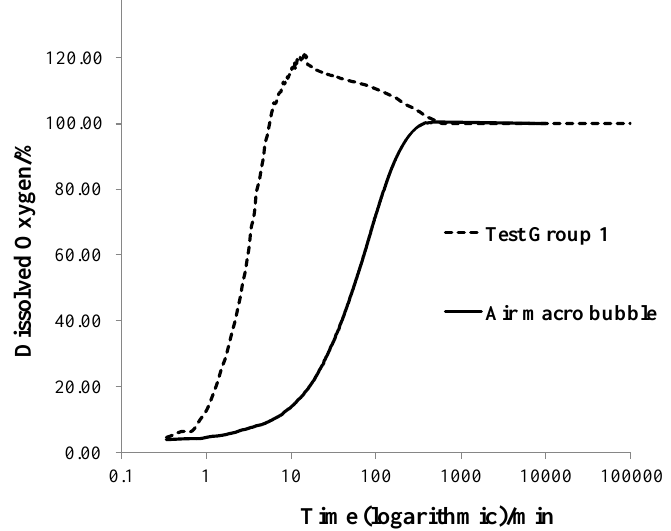
Figure 2. Dissolved oxygen changes with time of test group 1 and macro